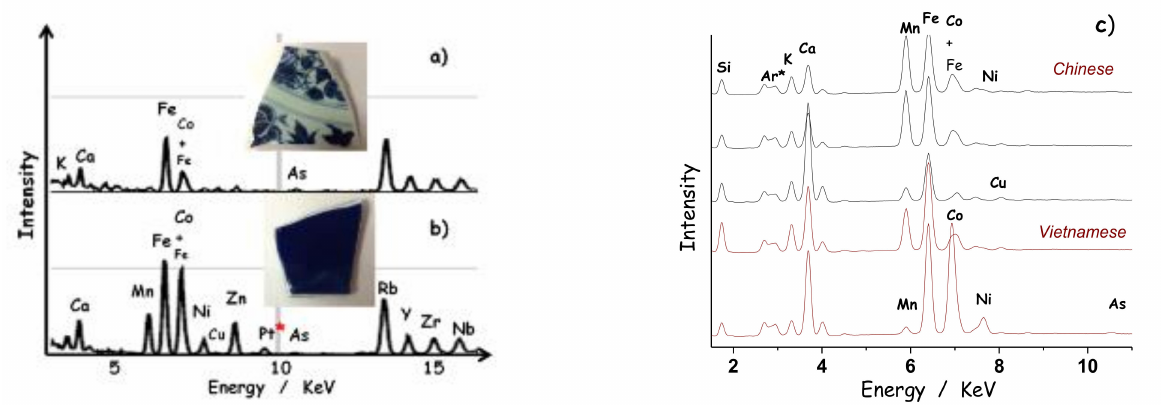
Figure 15. Examples of XRF spectra of various Chinese ( a – c ) [196] and Blue Print Collection [24] and Vietnamese ( c ), Chu Dau, Hua Luu, etc.) glazed sherds which represent different compositions of Co-containing blue pigments [21]. The sherd in ( a ) represents a fragment of a charger with a qilin and ( b ) represents a fragmentary stem bowl, both attributed to the productions of the Yuan Dynasty, 14th-Century